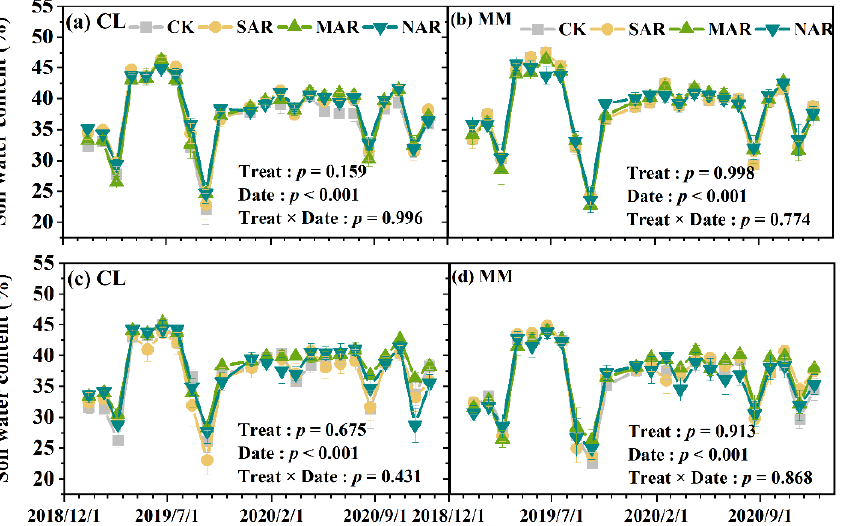
Figure 2. Seasonal variations in soil water content in untrenched plots ( a , b ) and trenched plots ( c , d ) under different types of acid rain in Cunninghamia lanceolata (Lamb.) Hook. (CL, a , c ) and Michelia macclurei Dandy (MM, b , d ) plantations from January 2019 to December 2020. Vertical bars represent standard errors ( n = 4).